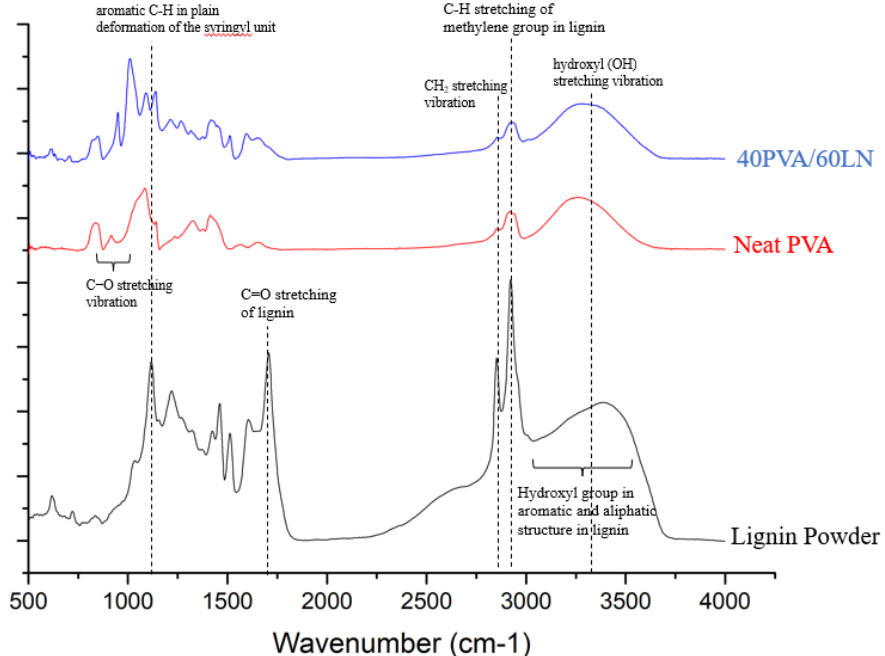
Figure 10. FT − IR spectra of mulch film PVA, PVA/lignin (40PVA/60LN), and lignin powder.